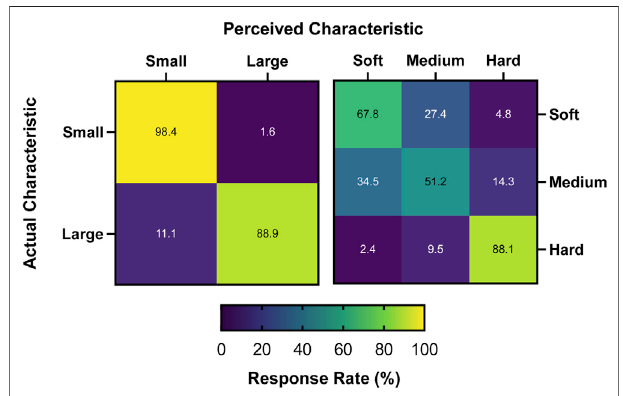
FIGURE7| Frequency ofclassifyingobjectsbytheirsizeindependentof compliance orcompliance independent ofsize.All classi fi cation combinations of sizeand compliance were assessed, with 4and 9 possible combinationsof classi fi cation in size (left) and compliance (right), respectively. Successful identi fi cation ofsizeorcompliance bychance are50%and 33%, respectively.